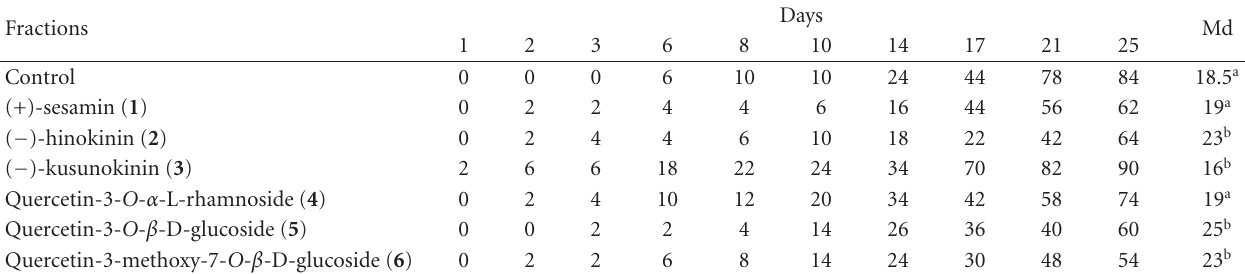
Table 3: A. sexdens rubropilosa workers mortality (%) and survival median (Md) when fed with diet containing the compounds 1 –